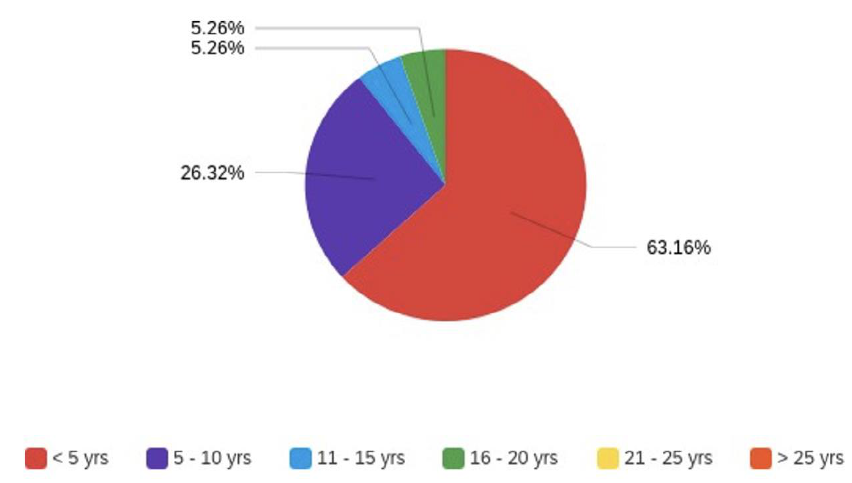
Figure 6. Experience of Survey Participants.